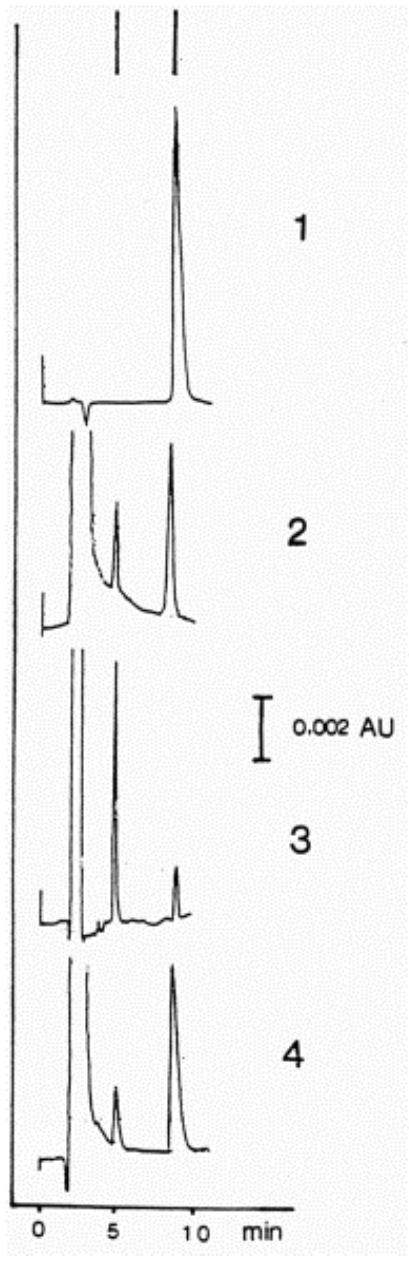
Figure 7. Identification of HNE and 4-hydroxynonenoic acid (HNA) by isocratic HPLC separation. Conditions: the eluent was 42% acetonitrile/water v/v 1 mL/min; columns were Spherisorb S5 ODS2 250 × 4.5 mm; detection of both substances at 223 nm; authentic standard of 4-HNA was produced in the system of HNE, dehydrogenase (NAD + ) and aldehyde dehydrogenase; ( 1 ) HNE standard solution 30 µM; ( 2 ) product of oxidation of HNE: HNA 15 µM; ( 3 ) mixture from cellular incubation mit CH oxidation; ( 4 ) mixture formed in rat liver cells (10 6 cells/mL) after addition of 100 µM HNE, the first peak representing HNA, the second peak representing HNE; for exact quantification of HNA the comparison of the HNA-peak with NADP formation in experiments on transition of HNE by means of aldehyde dehydrogenase was carried